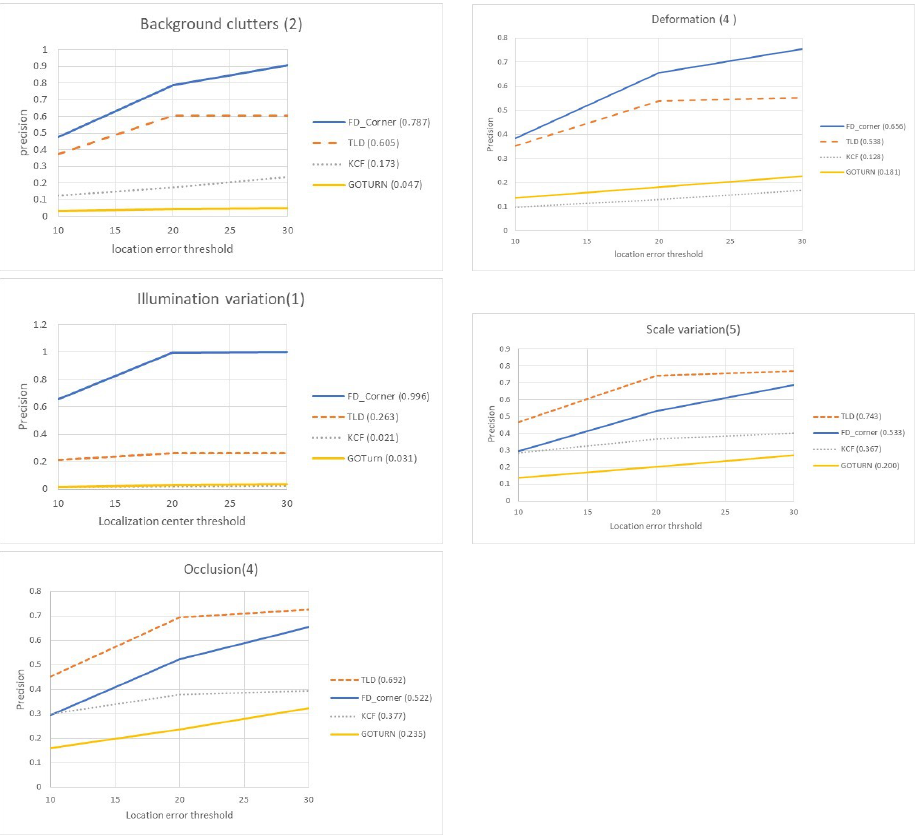
Figure 11. The precision plot for sequences with attributes: background clutter, deformation, illumination variation, scale variation and occlusion. Our FD Corner tracker perform favourably on background clutters, deformation and illumination variation